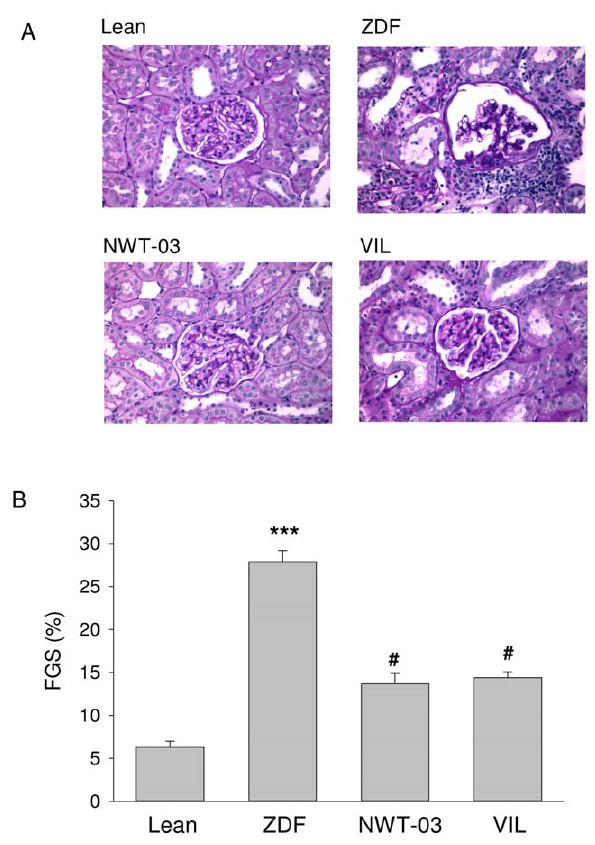
Figure 3. Renal morphology and FGS. (A) Shown are representative sections for lean control rats (top left) and untreated ZDF rats (top right), and ZDF rats supplemented with NWT-03 (bottom left) or treated with VIL (bottom right). (B) FGS (see Methods); data are means 6 SEMs (***p , 0.001 vs. lean; # p , 0.05 vs. ZDF).